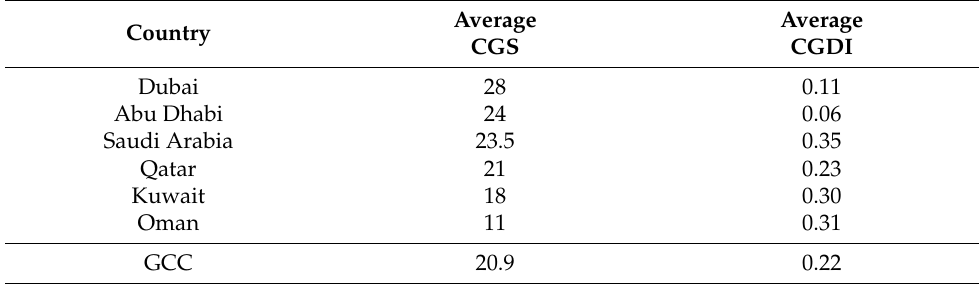
Table 5. Average CGS and CGDI score: a comparison. Country